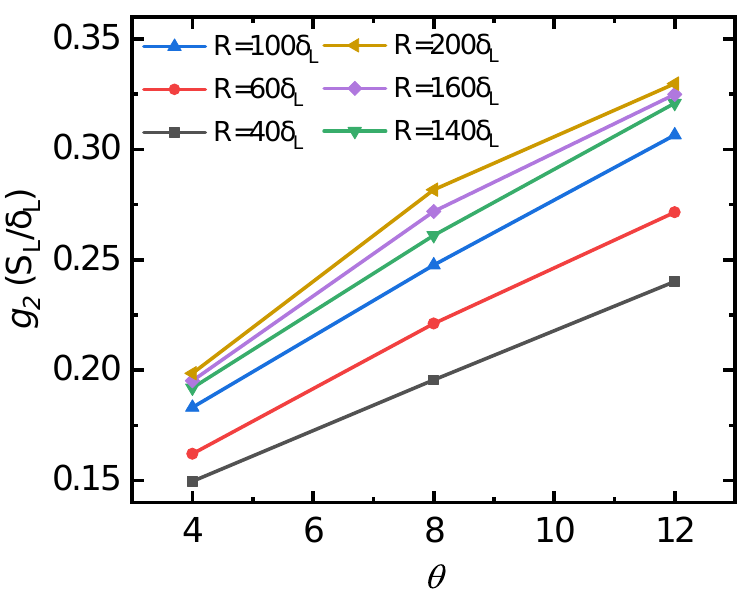
Figure 10. Critical inlet velocity gradient g 2 versus thermal expansion coefficient θ for different channel half-widths R , isothermal